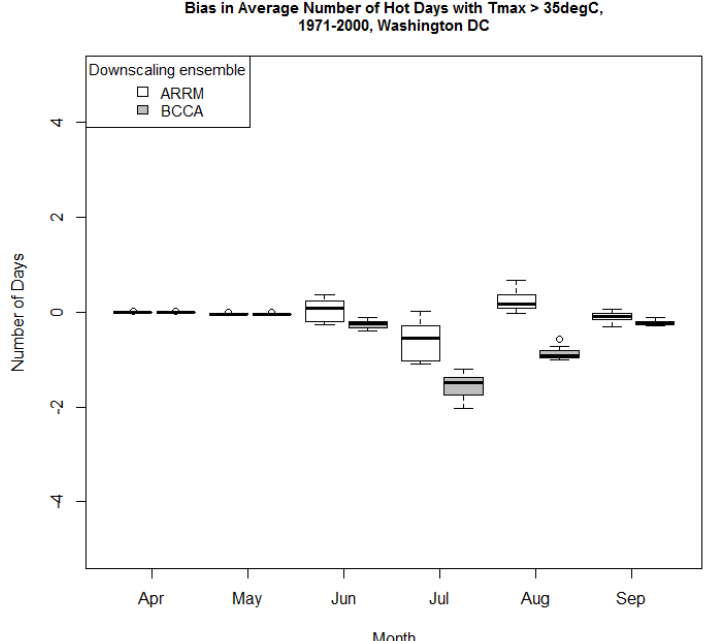
Figure 5. Absolute bias relative to Maurer02v2_1/8 observational dataset of the period mean HD35 for Washington DC for 1971–2000 as represented by the ARRM and BCCA downscaled GCM ensembles. Heavy line within each box plot represents the median.